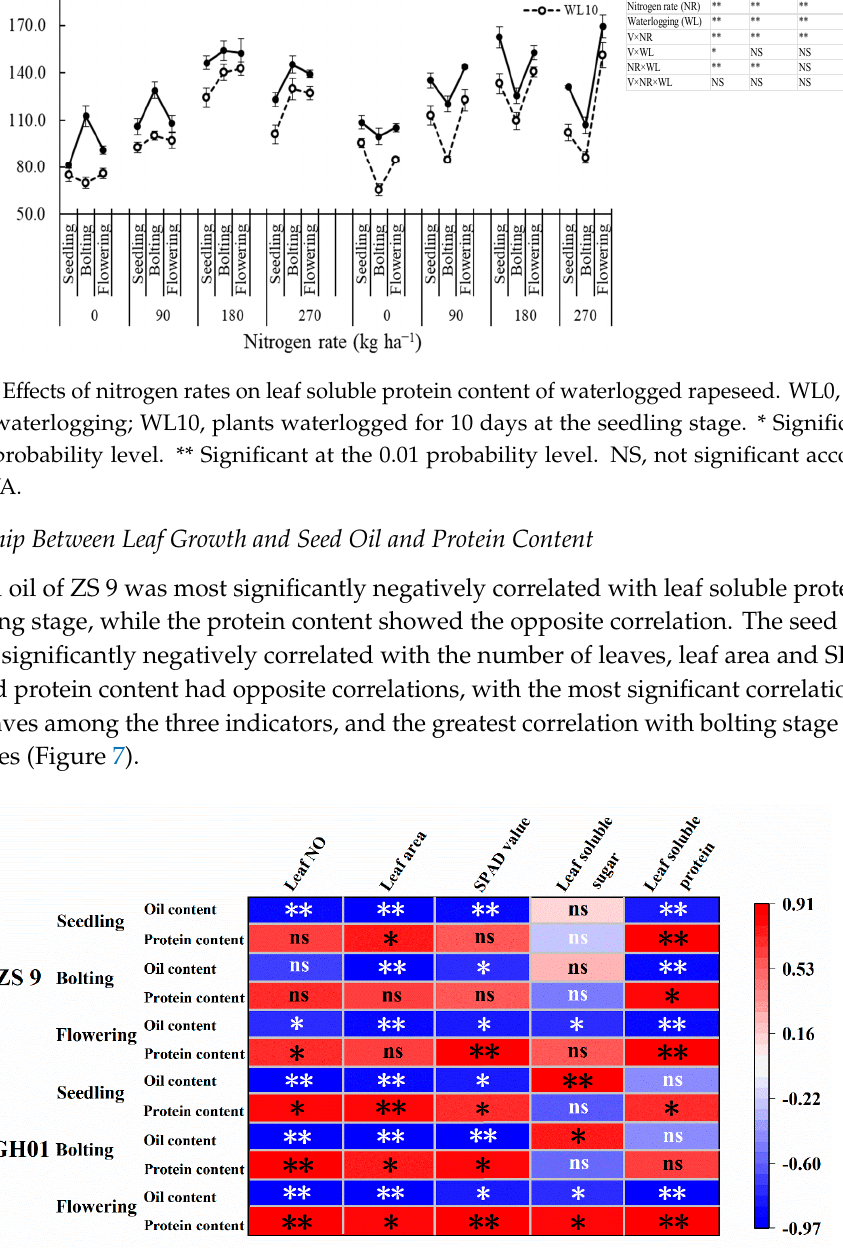
Figure 5. Effects of nitrogen rates on leaf soluble sugar content of waterlogged rapeseed. WL0, plants without waterlogging; WL10, plants waterlogged for 10 days at the seedling stage. ** Significant at the 0.01 probability level. NS, not significant according to ANOVA.